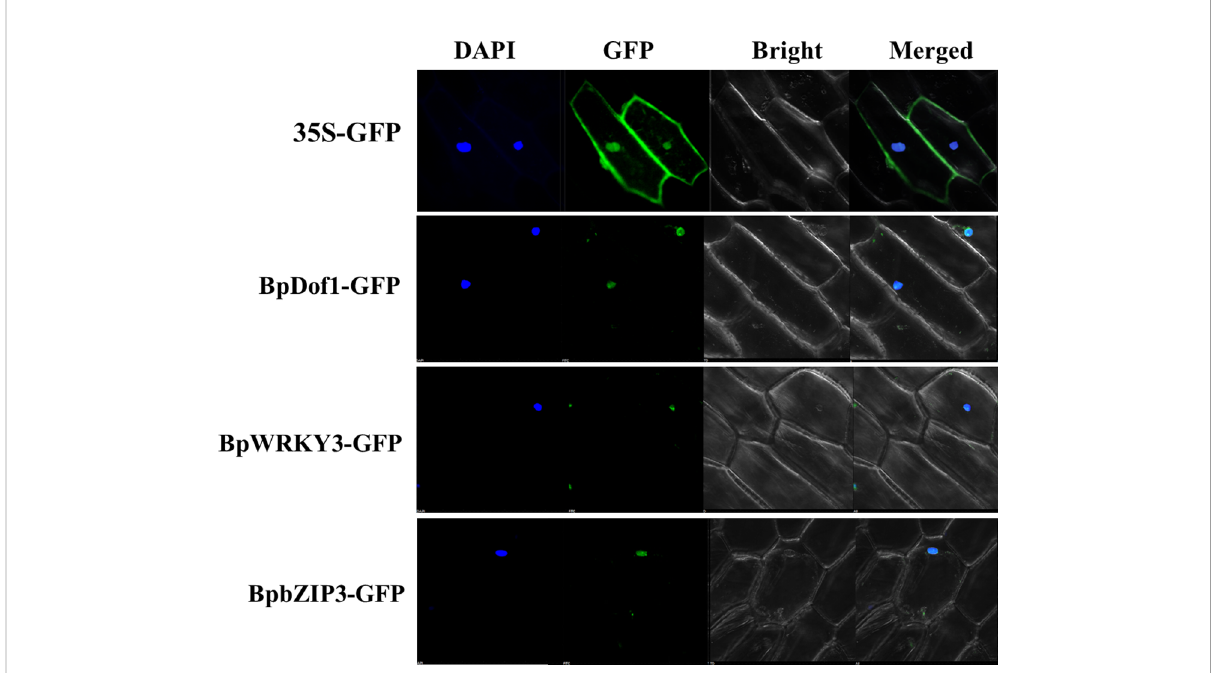
FIGURE 9 Subcellular localization of three upstream regulatory factors. The fusion genes of BpDof1 , BpWRKY3 , and BpbZIP3 with GFP , with 35S- GFP as the control, were transiently expressed in onion epidermal cells using the particle bombardment method. The transformed cells were cultured